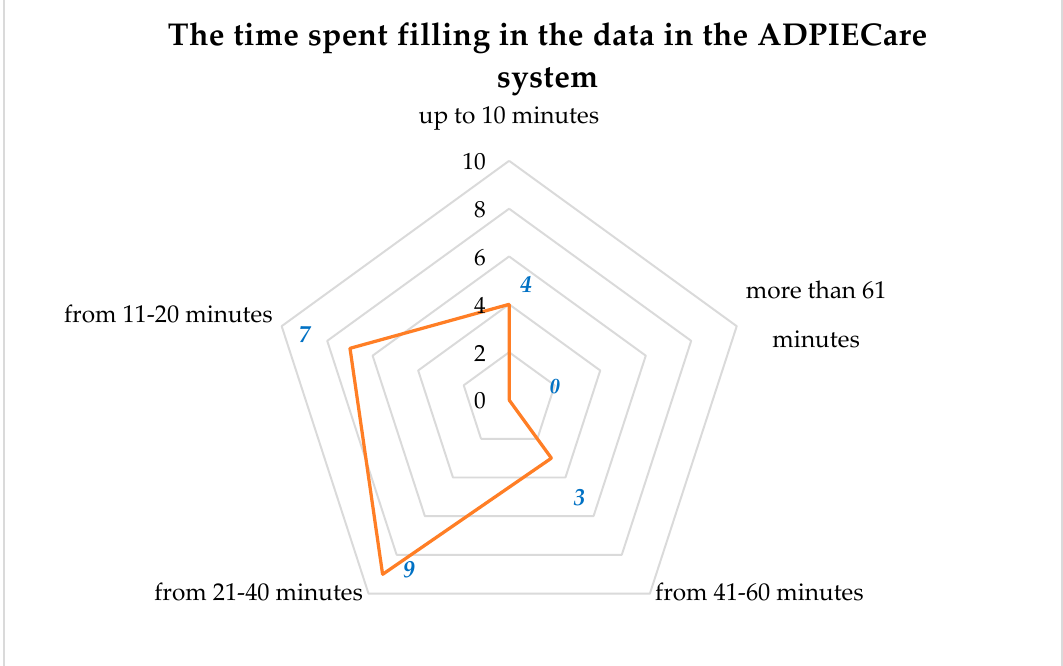
Figure 11. Time consumed by documenting the patient’s care plan.